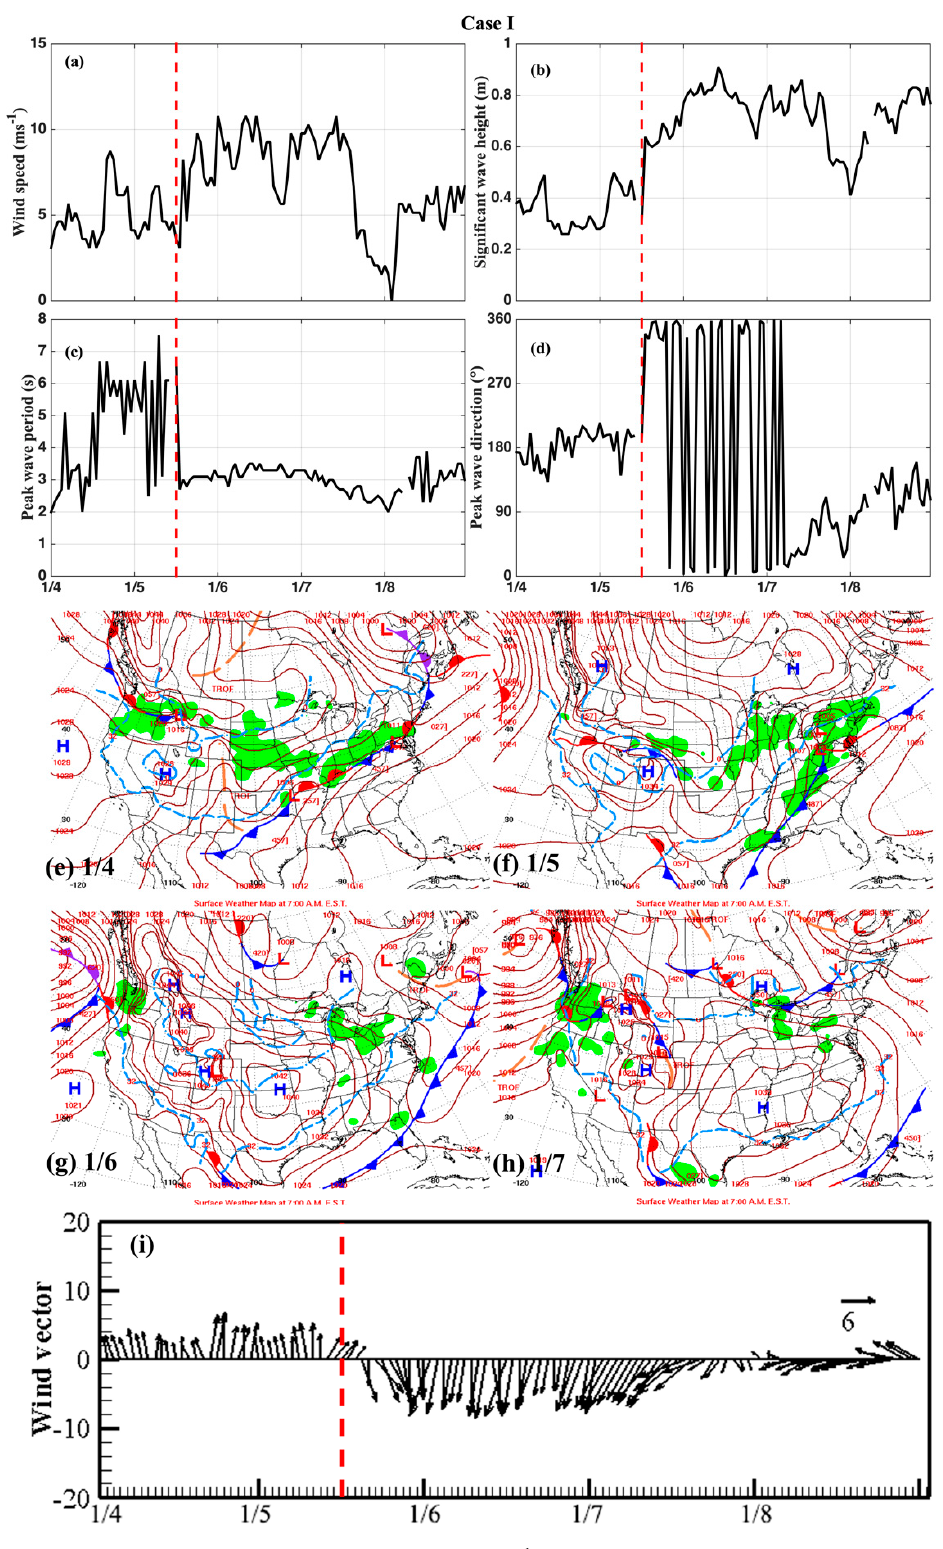
Figure 6. Case I: Time series of ( a ) wind speed (ms − 1 ), ( b ) significant wave height (m), ( c ) peak wave period (s), ( d ) peak wave direction ( ◦ ) and ( e – h ) surface weather map at 12:00 UTC from 4 to 7 January. Cold fronts are in blue lines with triangles on the warm side of the front. Low-pressure and high-pressure areas are denoted with L and H, respectively. Green patches are areas experiencing rainfall; ( i ) wind vectors from the station WS. The arrows indicate the air flow velocity or the direction that the air particle is taking. The red vertical dashed lines indicate the timing of the cold fronts.